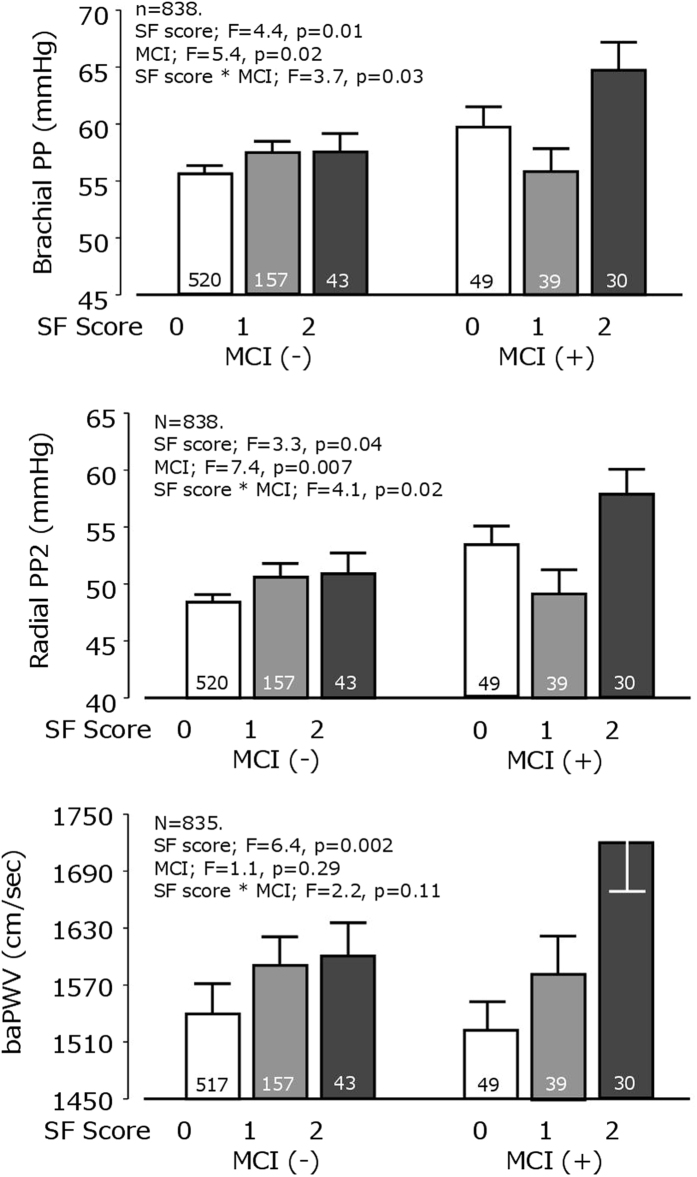
Relationship between simple frailty (SF) score, mild cognitive impairment (MCI) and brachial pulse pressure 2 (PP2), brachial pulse pressure (PP) and brachial-ankle pulse wave velocity (baPWV).The number in the column represents the number of participants. Adjustment was made for age, sex and mean blood pressure. Adjustment was performed using linear regression analysis with interactions between SF score and MCI presence.